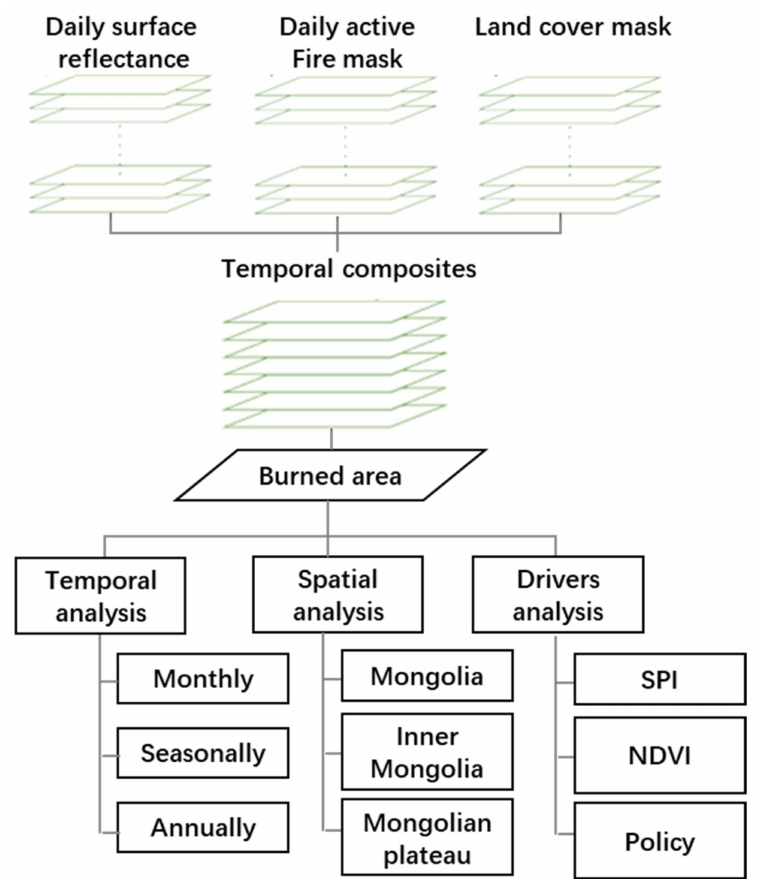
Figure 2. The technical route of the